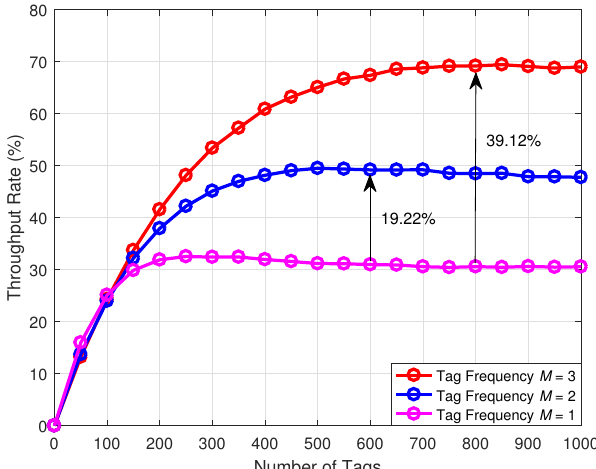
Figure 7. Comparison of the throughput rate with respect to the number of tags under the different number of